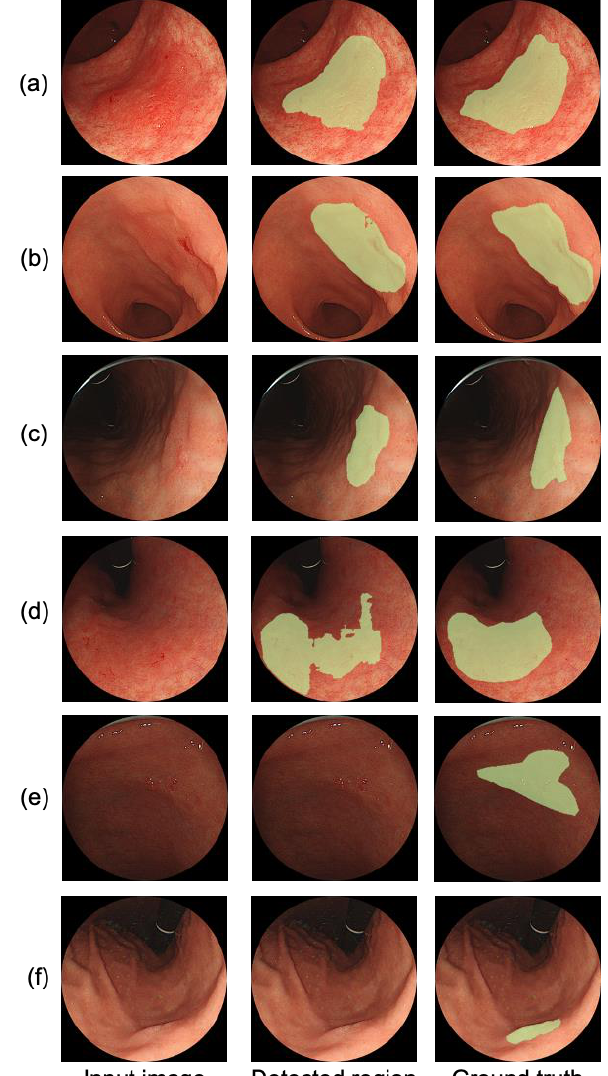
Figure 4. Lesions detected and missed in the initial detection process: ( a , b ) correctly detected by both the previous and the proposed method; ( c , d ) correctly detected only by the proposed method; ( e , f ) missed by the proposed method.